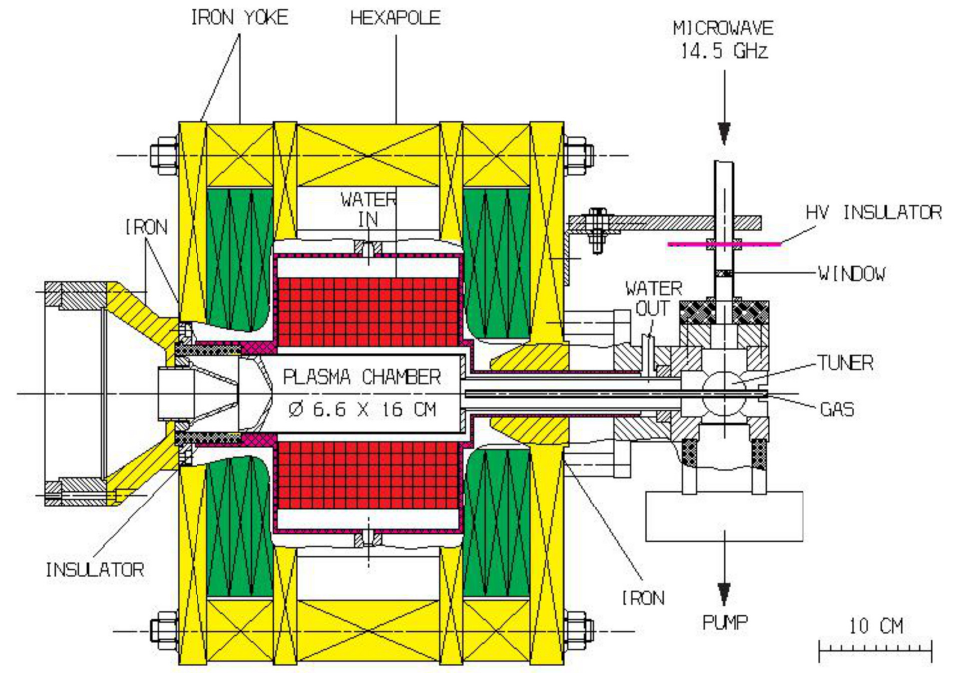
Figure 1. The Caprice ECRIS. Normal conducting coils (shown in green) together with a permanent magnet hexapole (shown in red). Microwave power is fed to the source from a high power generator at 14.5GHz, connected by waveguide to the ECRIS. Iron parts in yellow. Gas is injected from the side opposite to the extraction